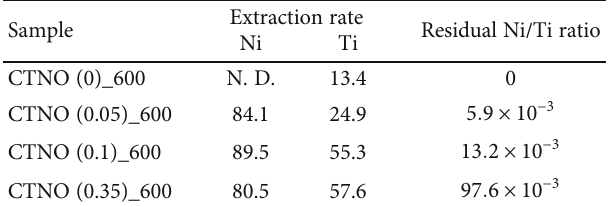
Figure 8: XPS spectrum of the Ni 2p region of HTNO (0.35)_600. Table 2: Extraction rates of Ti and Ni and the corresponding residual Ni/Ti ratios in the CTNO ( x )_600 samples after dilute HCl treatment.